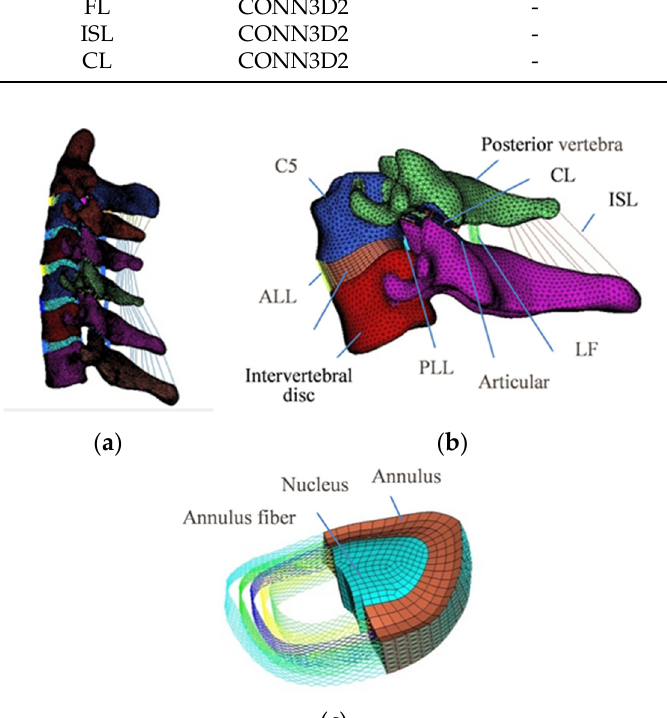
Figure 1. Components of each vertebra.